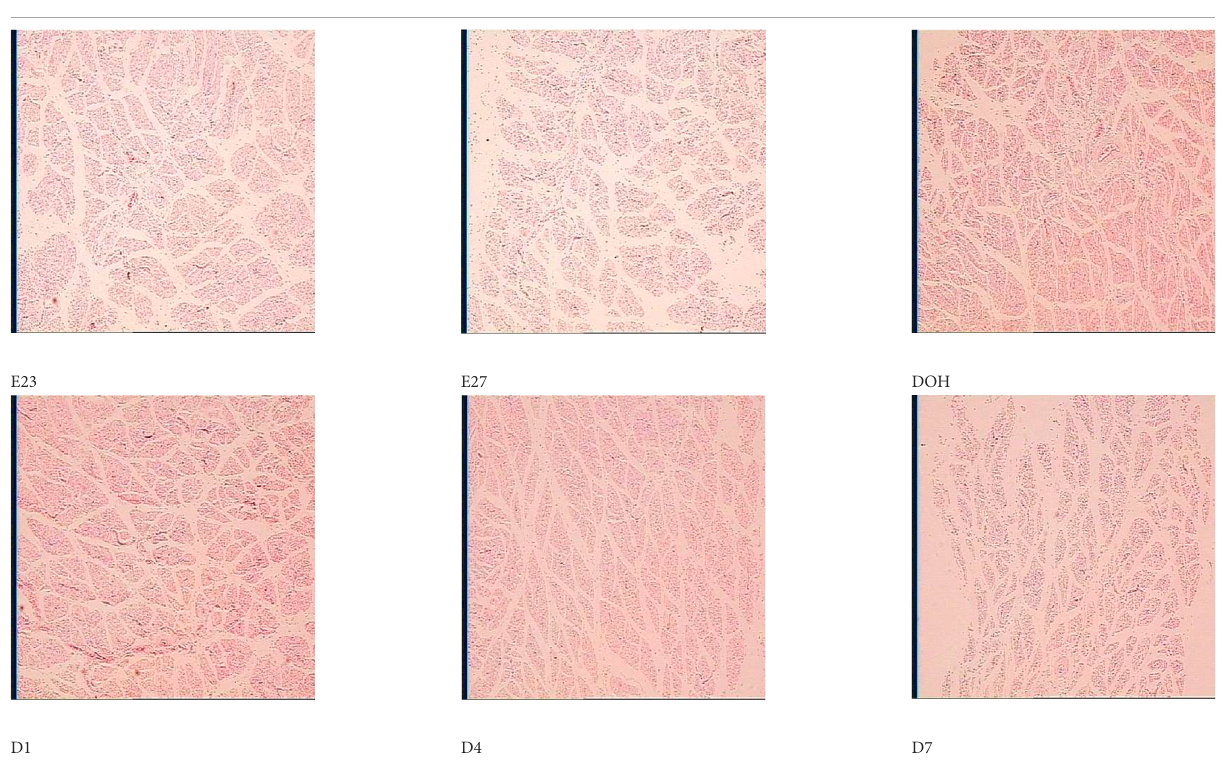
TABLE 6 Representative myo fi ber H&E stain slice of goslings between embryonic day 23 to day 7 post hatching a,b . Diameter of myo fi ber, 4 ×